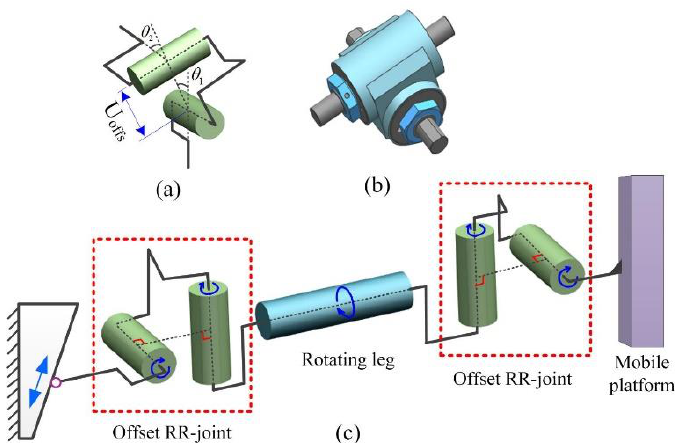
Figure 6. P -RR-R-RR kinematic chain: ( a ) Schematic diagram of offset RR-joint; ( b ) 3D model of offset RR-joint; ( c ) P -RR-R-RR kinematic chain composition.